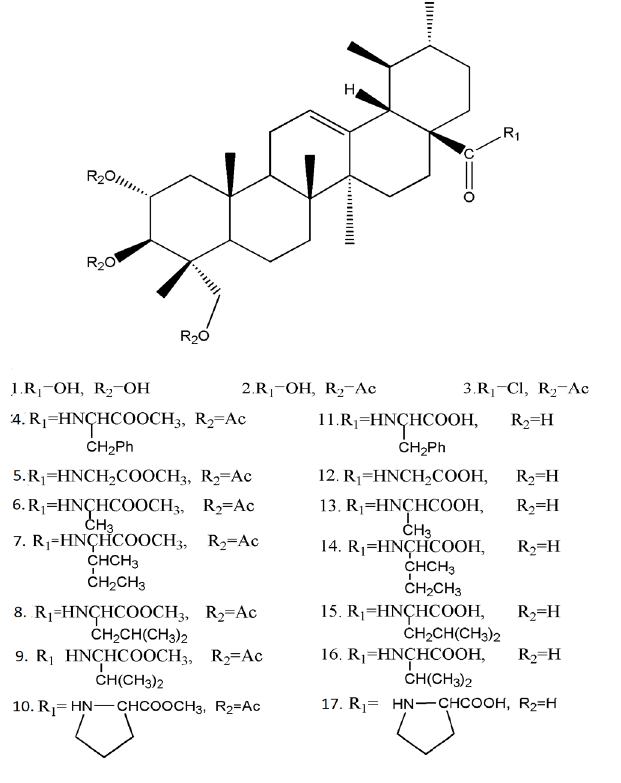
Figure 1. Structures of asiatic acid ( 1 ) and its derivatives 2 – 17 tested in the present